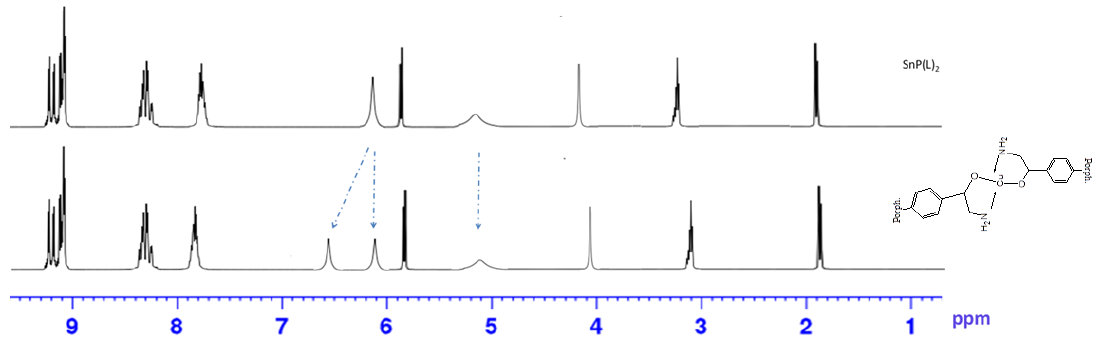
Figure 2. 1 H NMR-spectrum of the Sn(L) 2 P 6 and (Sn(L) 2 P) 2 Cu 7 . Figure 2. 1 H NMR − spectrum of the Sn(L) 2 P 6 and (Sn(L) 2 P) 2 Cu 7.